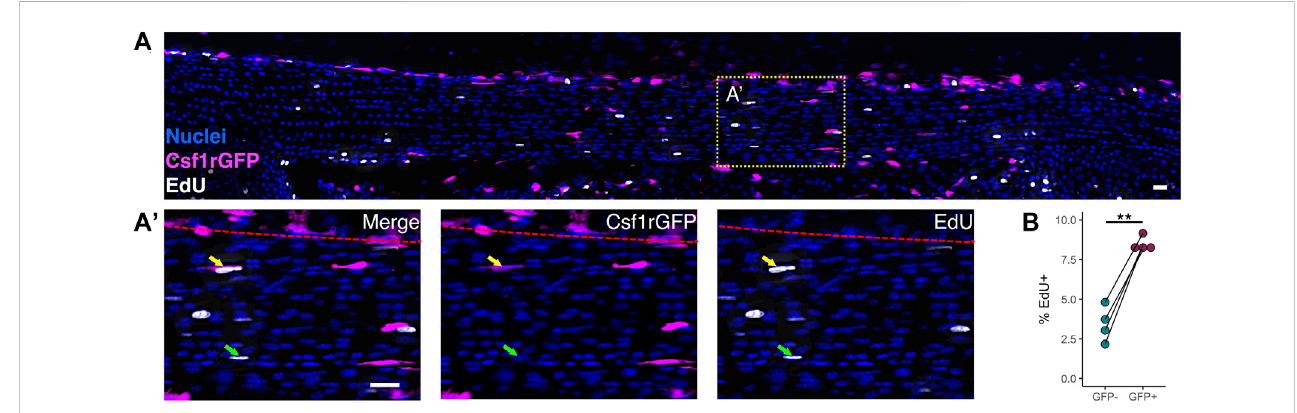
FIGURE 3 Macrophages proliferate at a higher rate than fi broblasts within the neonatal tendon (A) Representative image of EdU staining of proliferating cells in P1 Csf1rGFP patellar tendon sections. Green arrows indicate EdU + Csf1rGFP – cells; yellow arrows indicate EdU + Csf1rGFP + cells; red dotted lines indicate border between tendon fascicle and peritenon. Scale bar = 20 µm (B) Quanti fi cation of EdU + cells within Csf1rGFP – fi broblast and Csf1rGFP + macrophage populations ( n = 4). ** p < 0.01 as determined by paired t